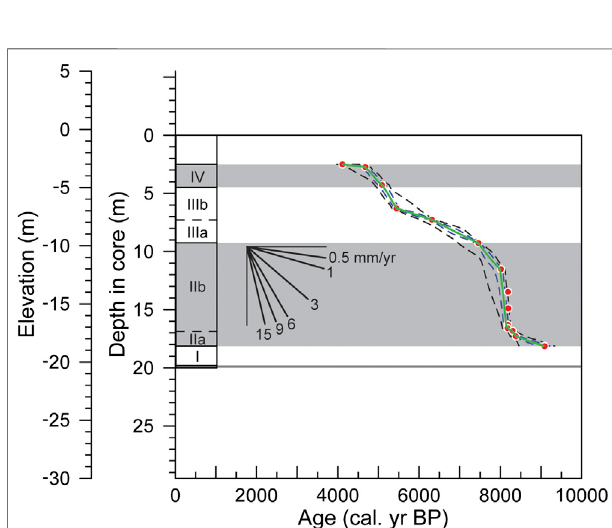
FIGURE 3 | Plot of the calibrated 14 C age data that are used for this study (also given in Table 1 ) with depth in core and elevation, and an age – depth model reconstructed by using the “ Undatable ” (Lougheed and Obrochta, 2019), with xfactor (cid:1) 0.1, bootpc (cid:1) 10, and 10 5 Monte Carlo iterationruns(see SupplementaryTableS6 ).Eachagedatapointisgivenby red- fi lledcircle. Theage-depthmodel medianisdenotedbygreenline.The1 σ and 2 σ uncertainties of the age-depth model are denoted by dashed blues and black lines, respectively. The sedimentary unit divisions (I to VI) are supplementarily shown near the y